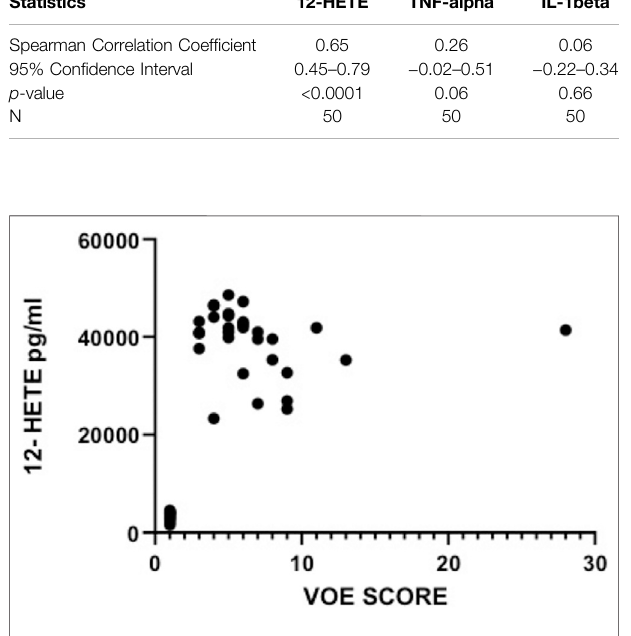
FIGURE 4 | Plasma 12-HETE levels in relation to VOE Scores of sickle cell disease patients.